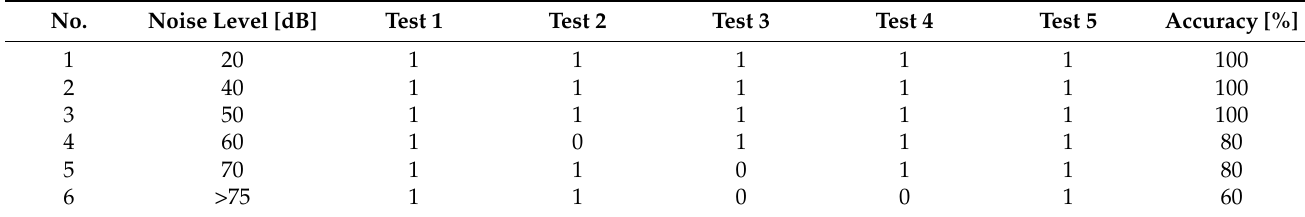
Table 3. Test cases for voice message recognition.